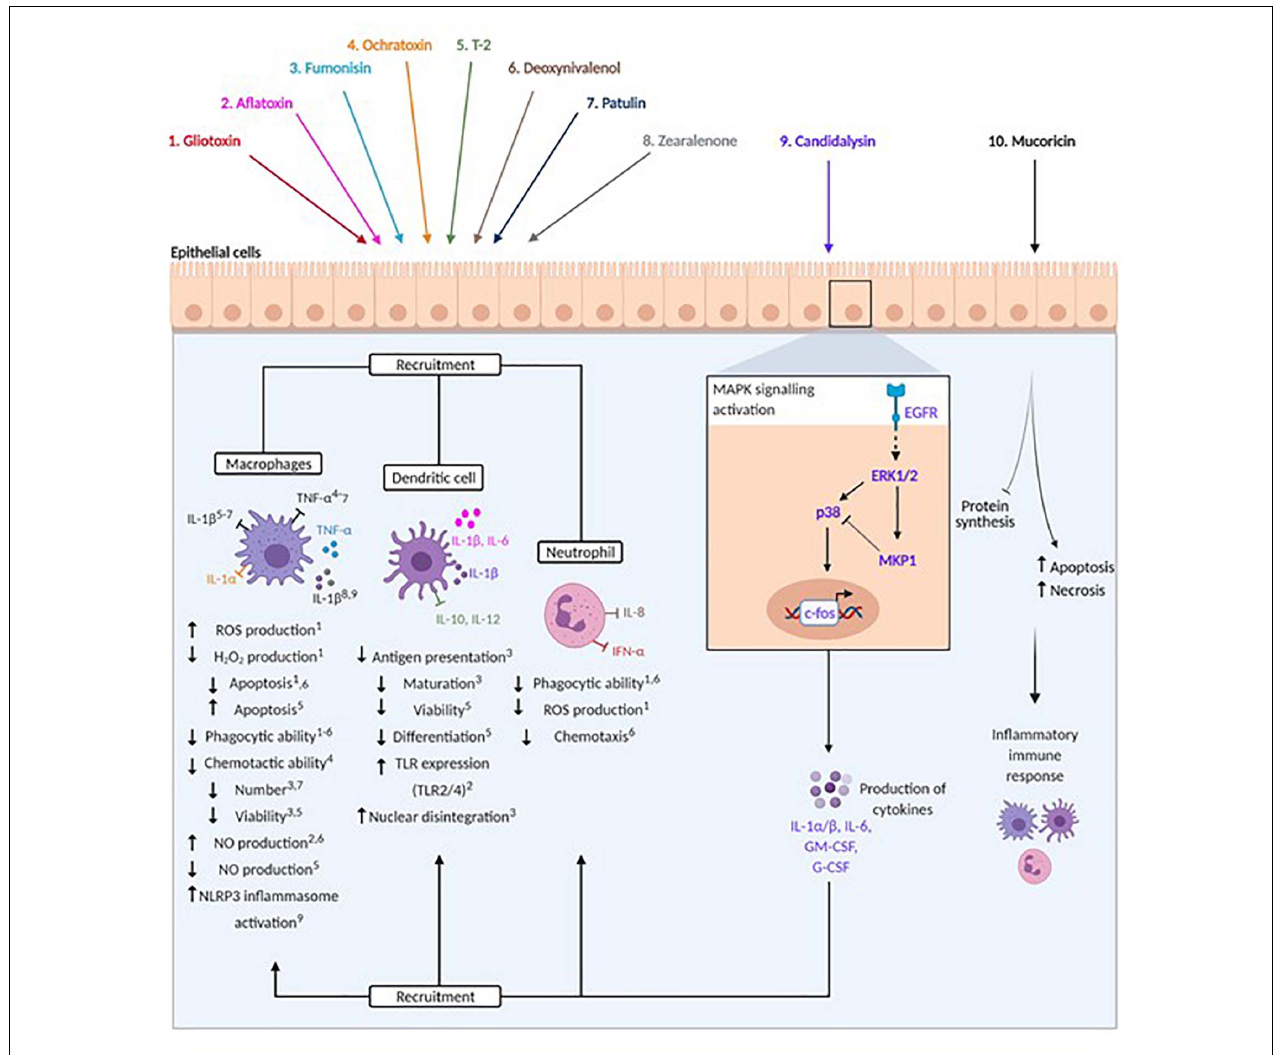
FIGURE 2 | Modulation of host immunity by mycotoxins, peptide and protein toxins. Fungal toxins are represented by colours: 1. Gliotoxin (red), 2. Aflatoxin (pink), 3. Fumonisin (light blue), 4. Ochratoxin (orange), 5. T-2 (green), 6. Deoxynivalenol (brown), 7. Patulin (dark blue), 8. Zearalenone (grey), 9. Candidalysin (purple), 10. Mucoricin (black). Arrows beneath immune cells denote promotion or reduction of indicated processes. Numbers in superscript identify processes affected by specific toxins. Pro- and anti-inflammatory cytokines are indicated by spheres and arrows (stimulation) and blunted arrows